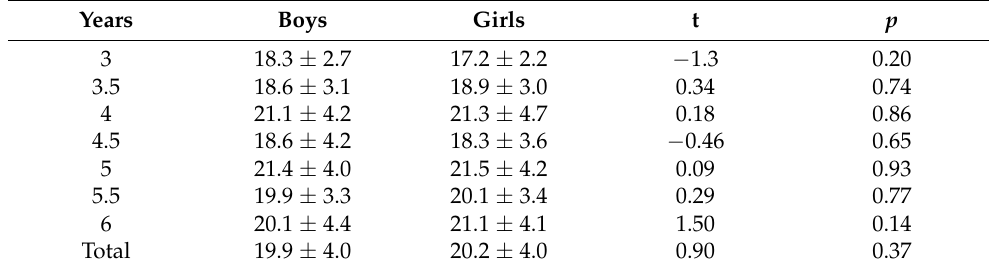
Table 3. Gender difference in body weight ( X ± SD, kg).